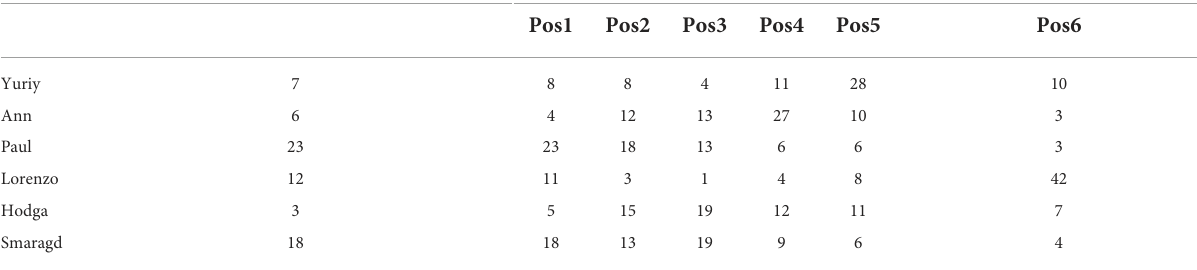
TABLE 8 Student preferences before and at the end of the questionnaire. Welcome page Ranking